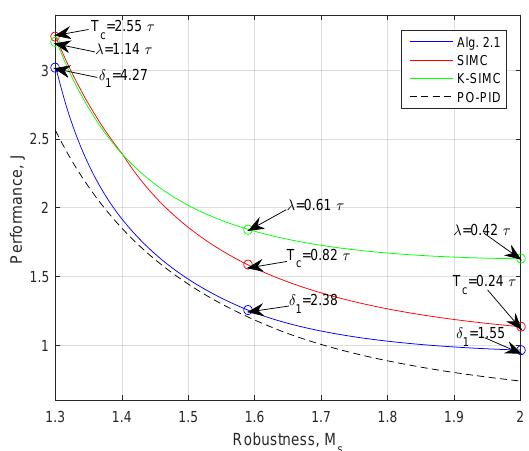
Figure 5: Example 3.2: Performance vs. robustness, J vs. M s trade-off curves. Comparing Alg. 2.1, SIMC and K-SIMC vs. the PO-PID con- trollers for the process model at row 2,